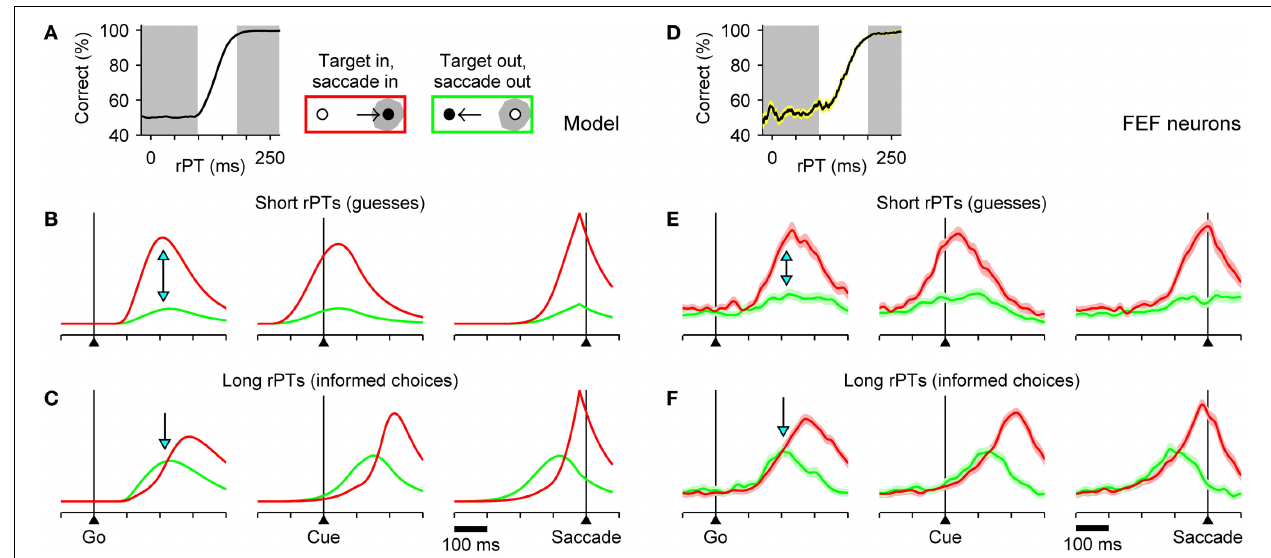
FIGURE 4 | Comparison between model and FEF neuronal responses. The accelerated race-to-threshold model was simulated with parameters that fitted the behavioral data of Money S, as in Figure 3 , and the simulated activity averaged across trials was compared to that recorded from motor-related neurons in FEF. (A) Simulated tachometric curve. Gray shades indicate ranges used to sort the simulated trials into short- (left shade, guesses) and long-rPT (right shade, informed choices) groups. (B,C) Average model responses for short- (B) and long-rPT (C) trials aligned either on the go signal (left column), the cue (middle column), or saccade onset (right column).